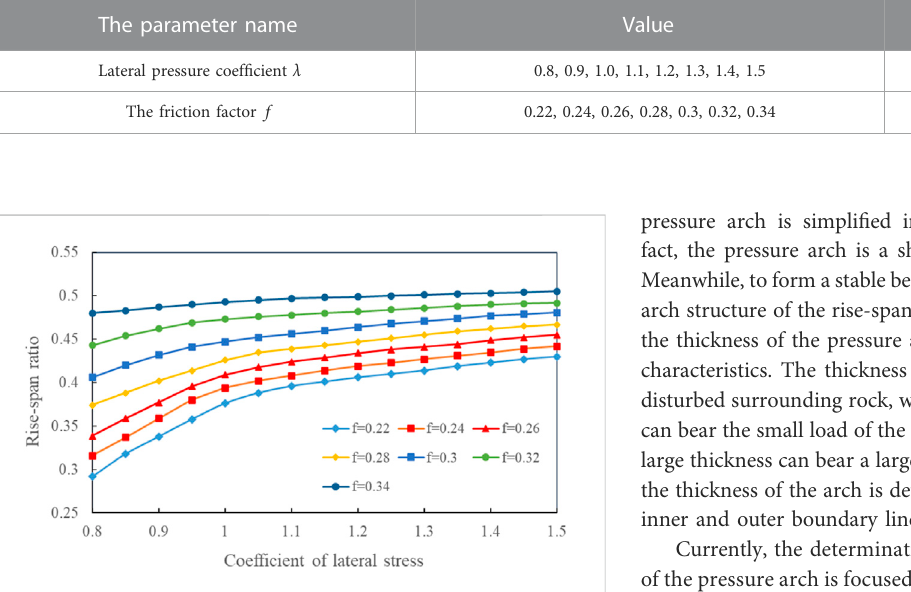
FIGURE 5 Variation law of rise-pan ratio of SRPA (Surrounding rock pressure